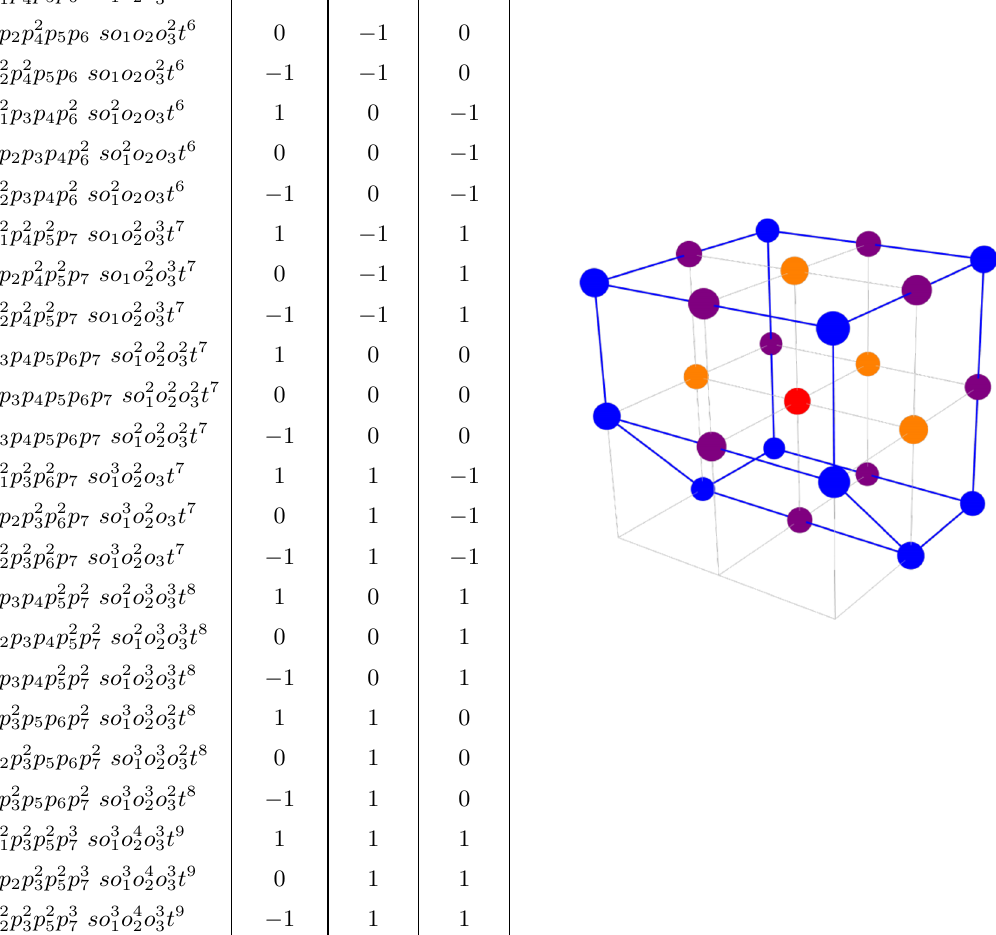
Table 64 . The generators and lattice of generators of the mesonic moduli space of Model 16 in terms of brick matchings with the corresponding flavor